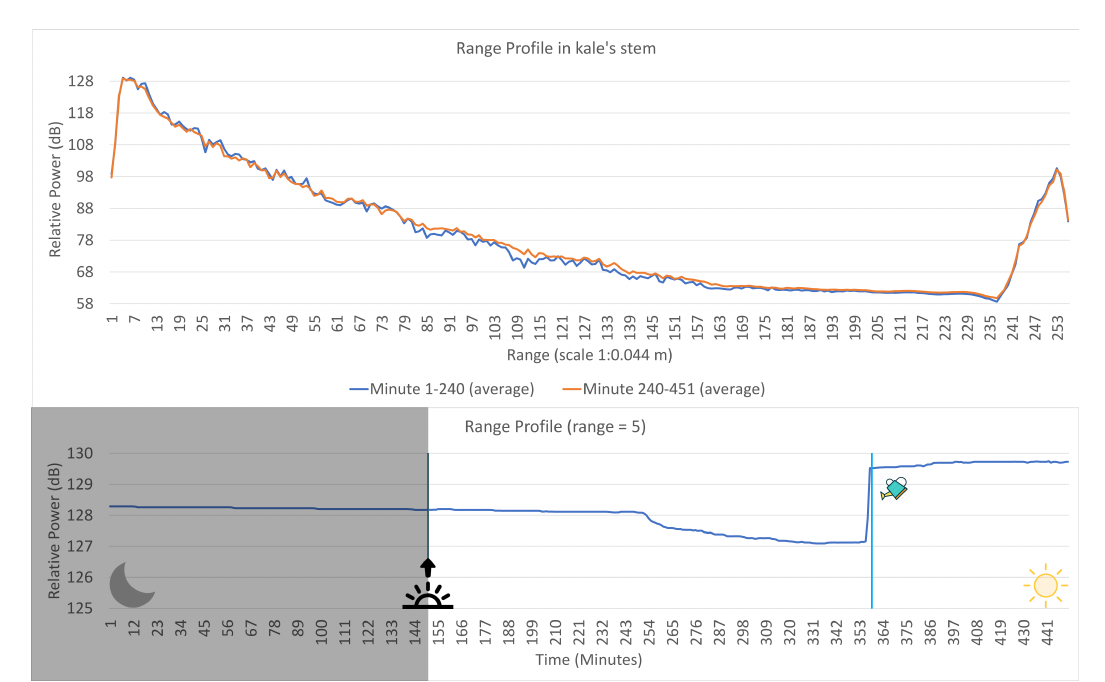
Figure 16. Result of the second test with kale’s stem during the night/day transition; vertical black line: sunrise; vertical blue line: